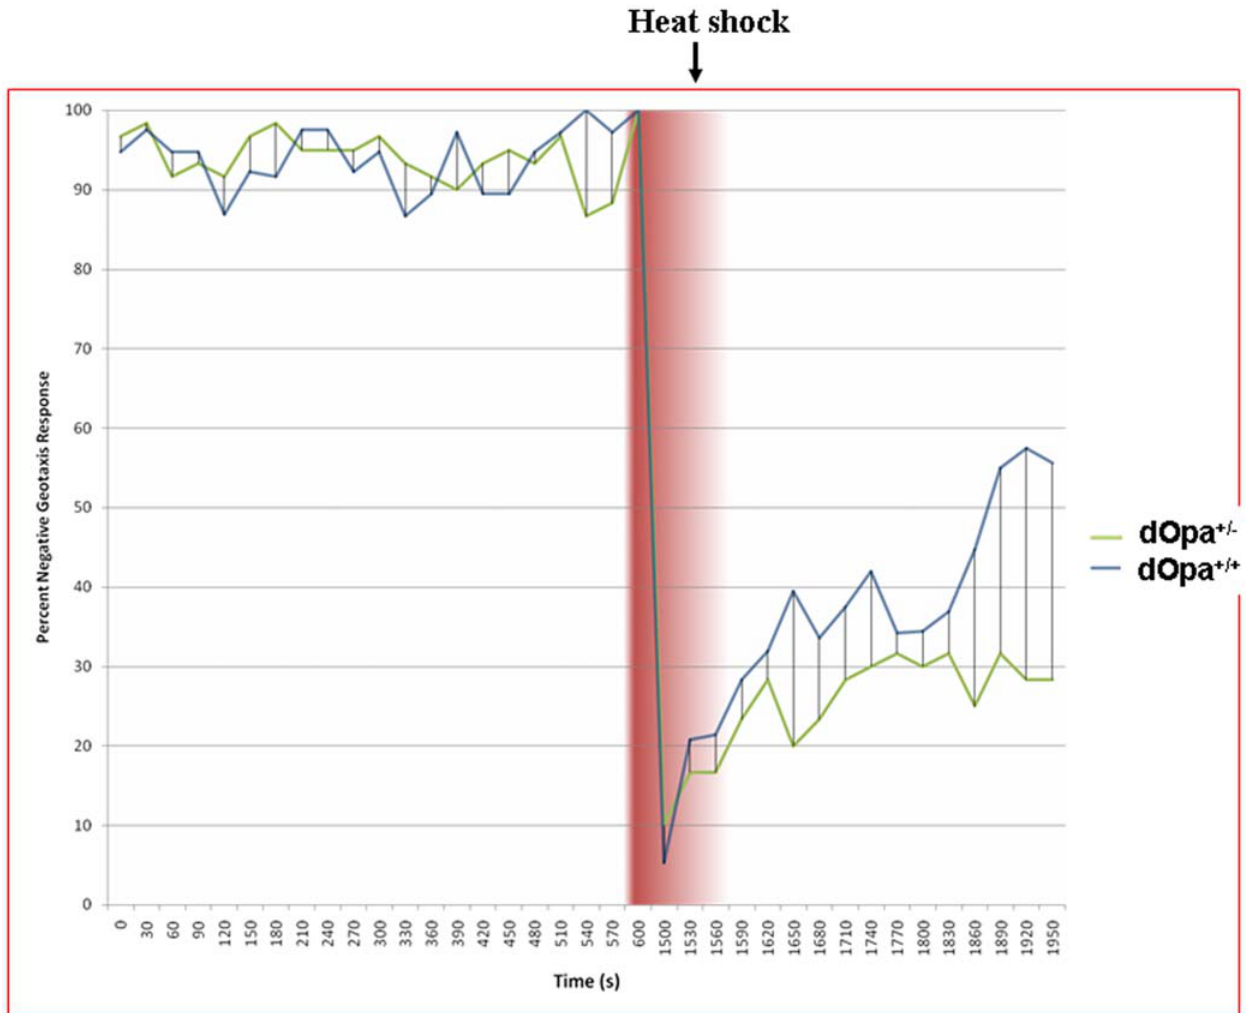
Figure 7. dOpa1 mutation impairs the ability of Drosophila to exhibit a negative geotaxis response following a heat shock. Seven d.o. Drosophila were places in 9 6 2 cm tubes with a line drawn horizontally 1 cm from the base. Every 30 seconds, the tubes were tapped until all Drosophila were at the bottom of the tubes. A baseline locomotive index (number of Drosophila above the 1 cm line after 15 seconds) was established at 22 u C. Drosophila were then subject to a 20 minute 37 u C heat shock and returned to 22 u C. Subsequently, the locomotive indexes were recorded as the samples recovered.